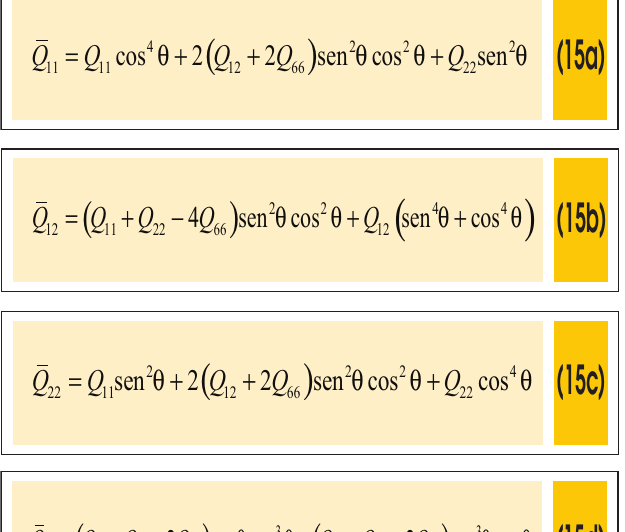
Figure 2 – Coordinate system and layer numbering used for a laminated